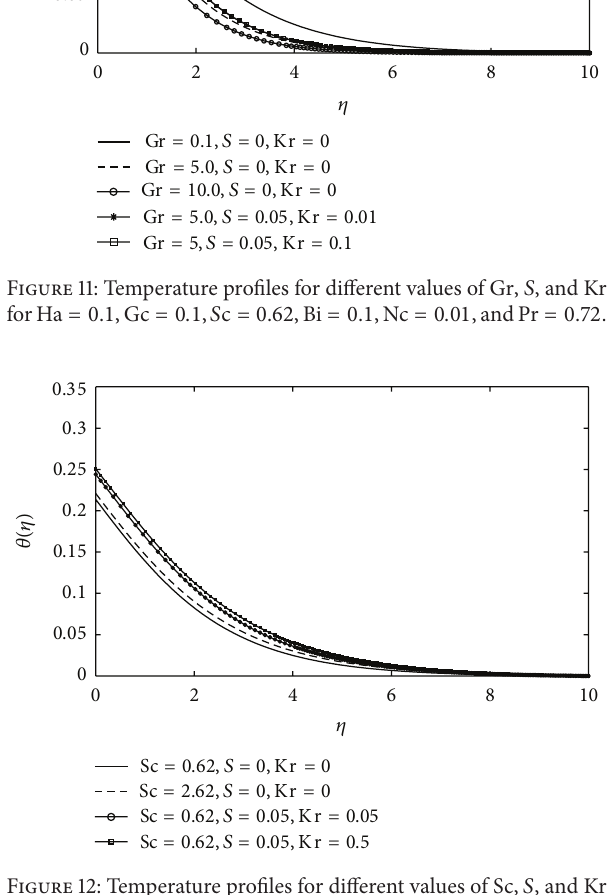
Figure 10: Temperature profiles for different values of Gc, 𝑆 , and Kr for Ha = 0.1 , Gr = 0.1 , Sc = 0.62 , Bi = 0.1 , Nc = 0.01 , and Pr = 0.72 . shows that thermal boundary layer thickness decreases as the Prandtl number increases implying higher heat transfer.